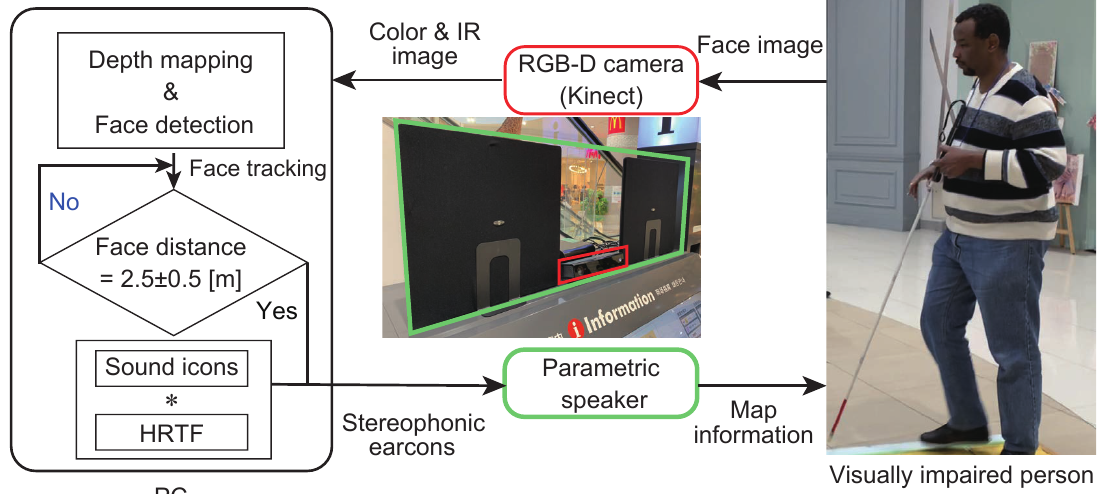
Figure 3. Block diagram of the proposed method: Face recognition is performed using images from an RGB-D camera. When a face approaches a certain distance, a stereophonic sound including map information is presented by a parametric